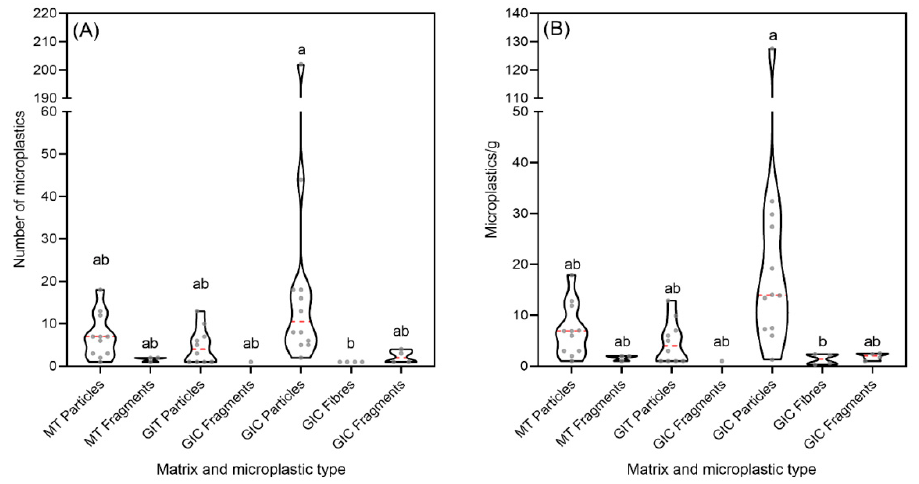
Figure 2. Violin plots of types of microplastics in nase individuals. ( A )—total frequency of microplas- tic types. ( B )—microplastic types based on the analyzed matrix weight. The red dotted line represents the median, the staggered dots are the data points, and the letters above the groups denote statistically significant differences ( p < 0.05); gastrointestinal tissue (GIT), the gastrointestinal content (GIC) and muscle tissue (MT).